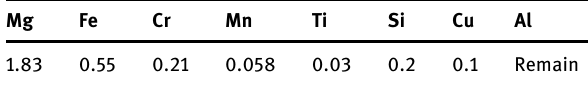
Table 1: Chemical composition of Al 5251 aluminium alloy ( wt% )